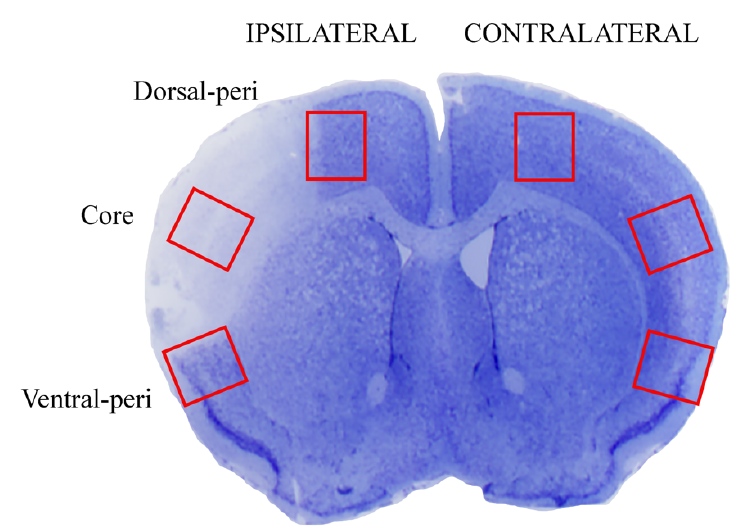
Figure 3. Representative picture of dissected regions.